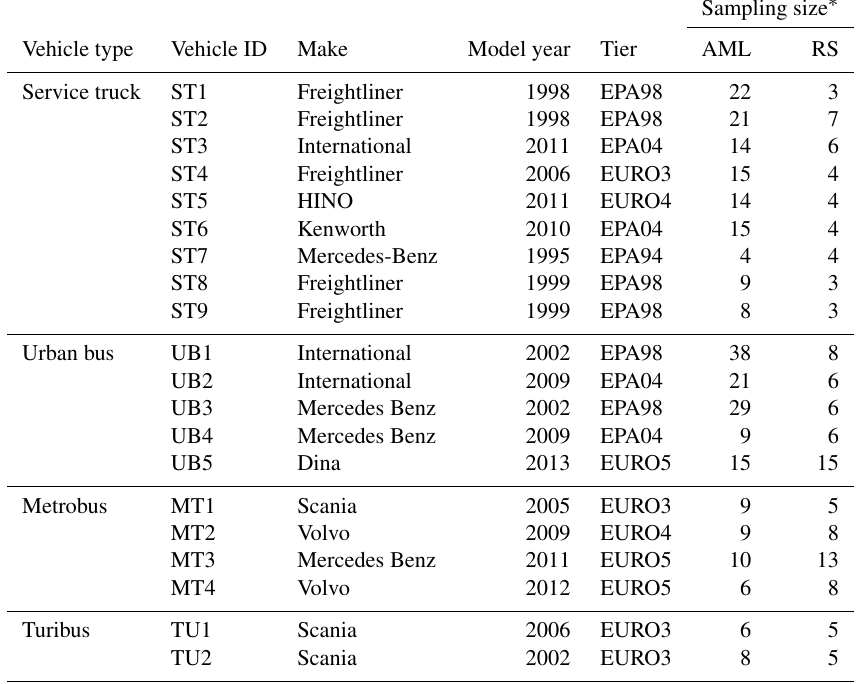
Table 1. Summary of sampled vehicle